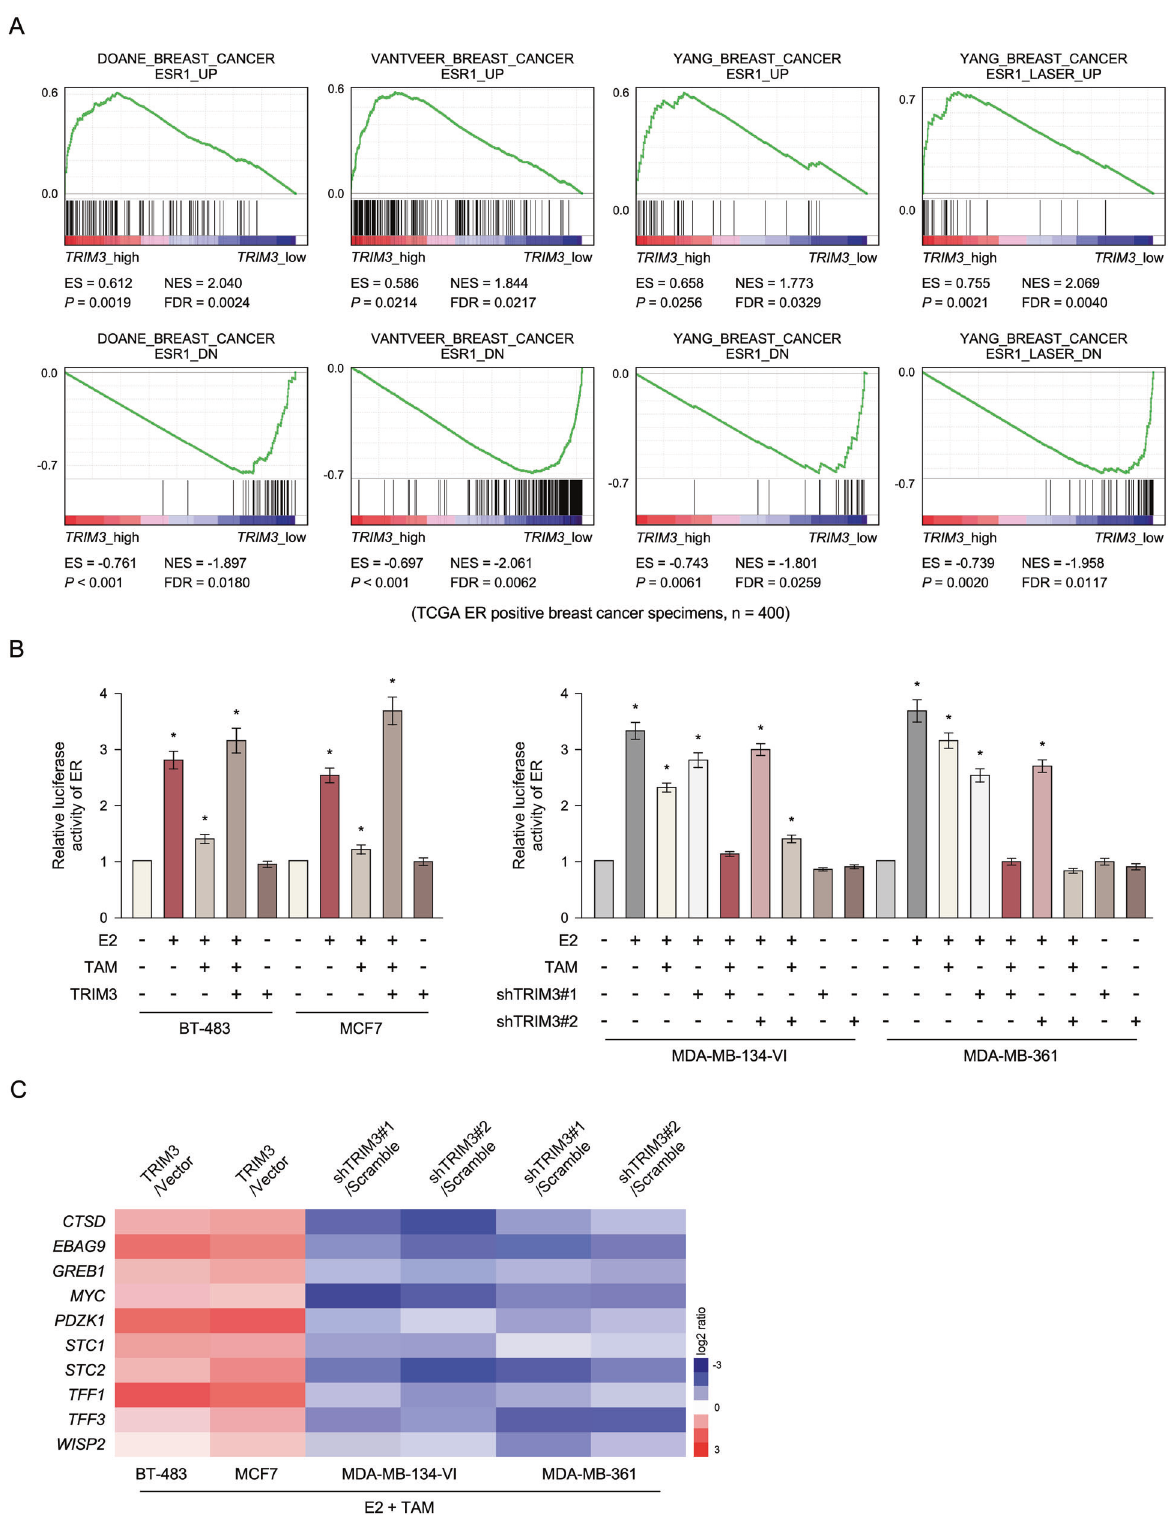
Fig. 3 TRIM3-induced estrogen receptor (ER)-dependent transcription in response to tamoxifen therapy. A GSEA showed that TRIM3 expression correlated positively with ESR1-activated gene signatures and negatively with ESR1-suppressed gene signatures in ER + breast cancer pro fi les (TCGA, n = 400). B Estrogen response element (ERE) luciferase reporter activity was analyzed in the indicated cells treated with E2 (10 nM) and/or TAM (1 μ M). Data are presented as the mean ± SD. * P < 0.05. C Heatmap of ER-regulated gene expression in the indicated cells treated with E2 and